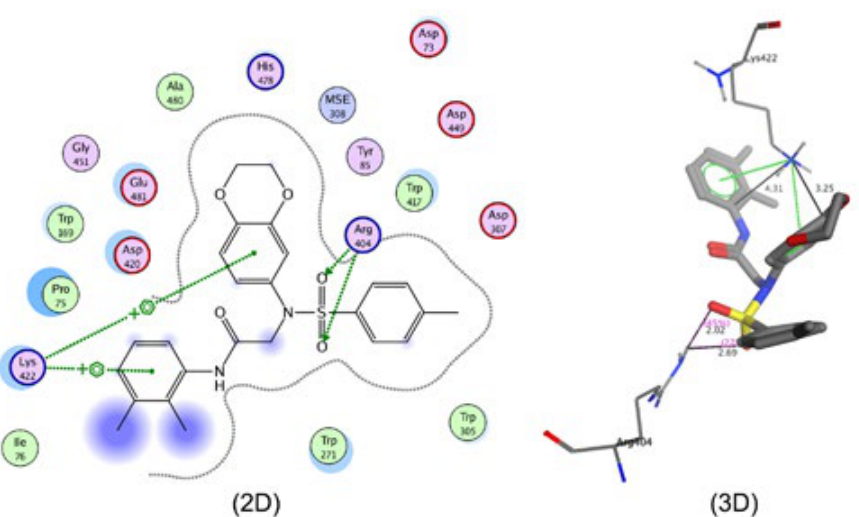
FIGURE 1 - Molecular docking of 7h against α-glucosidase.